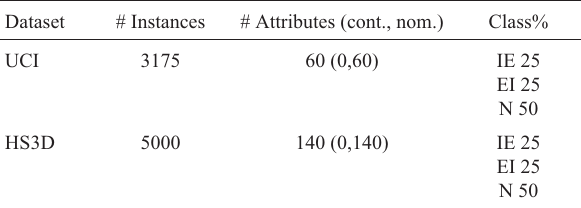
Table 1 - Datasets summary